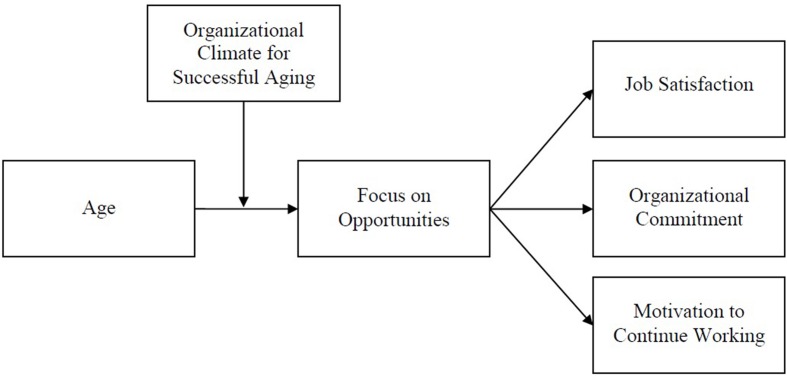
Conceptual model.